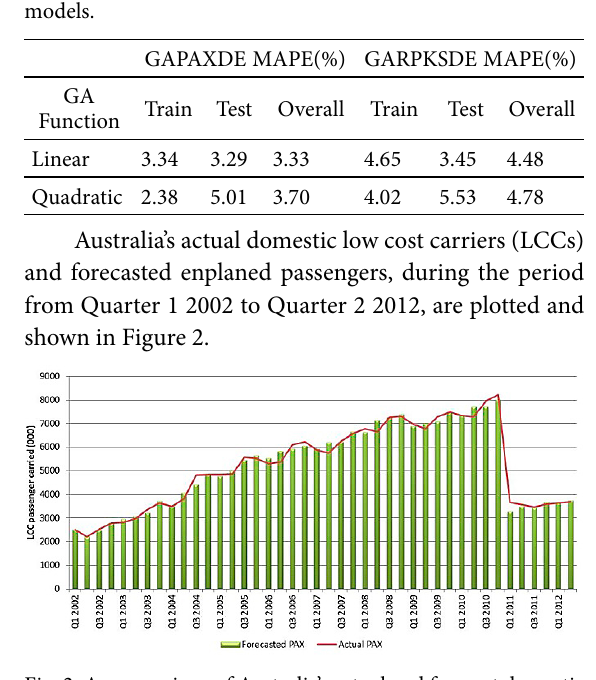
Fig. 2. A comparison of Australia’s actual and forecast domestic low cost carriers enplaned passengers (GAPAXDE Model).